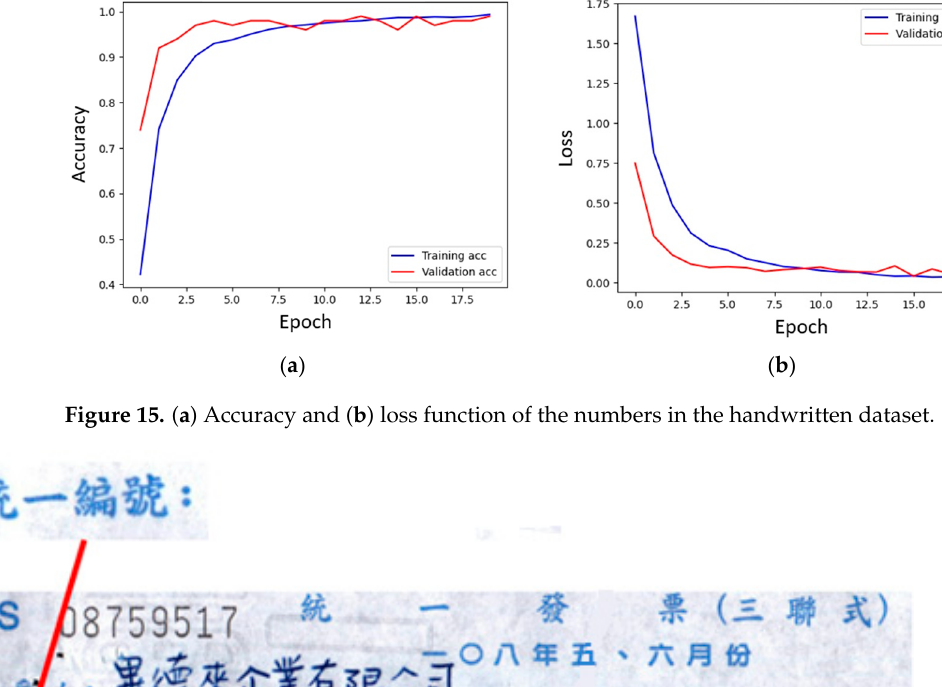
Figure 14. Numbers in the handwritten dataset .